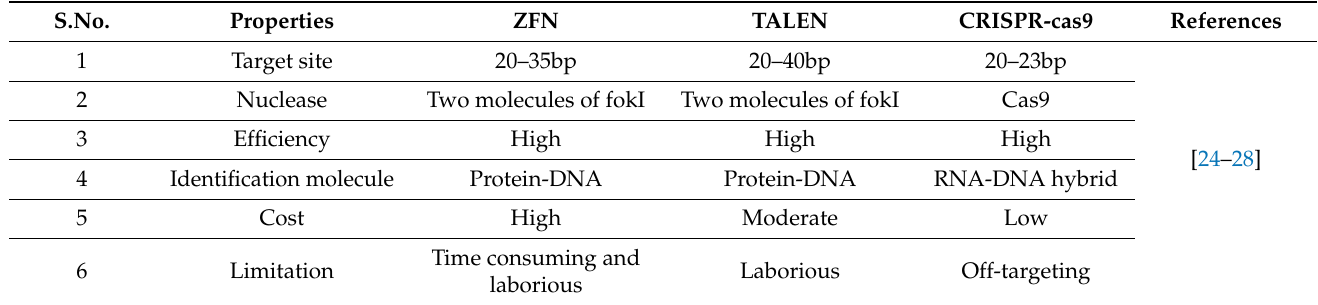
Table 1. Comparative table of engineered